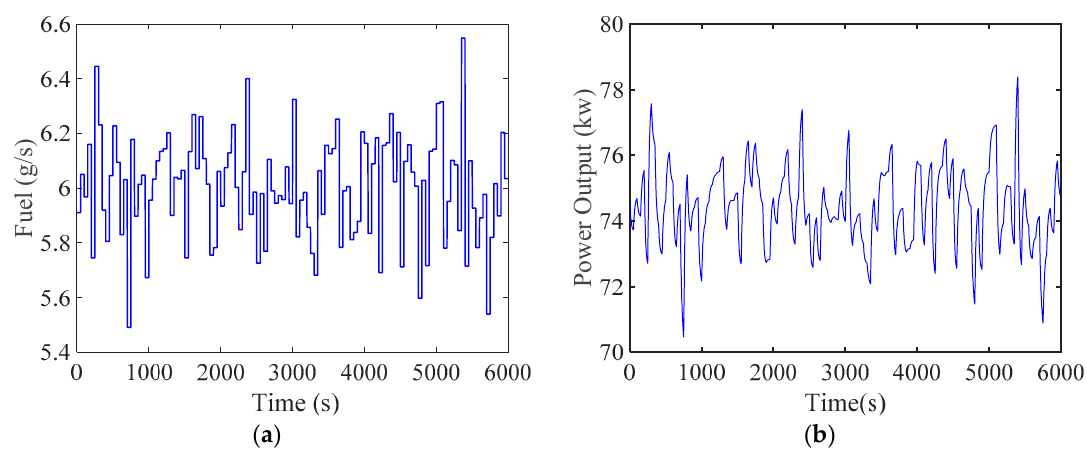
Figure 6. Identification data (power generation system). ( a ) input command data; ( b ) output data.